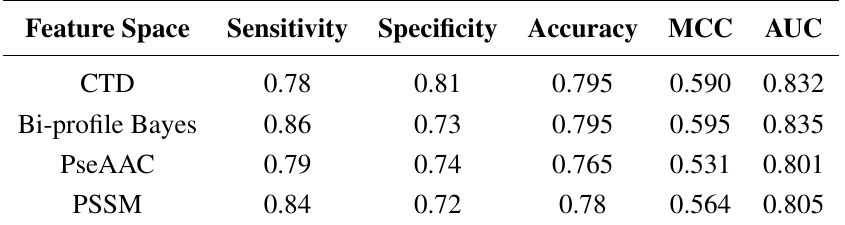
Table 1. Performance of RF models trained with the best-performing individual feature spaces on the training dataset by 10-fold cross-validation. MCC, Matthew’s correlation coefficient.